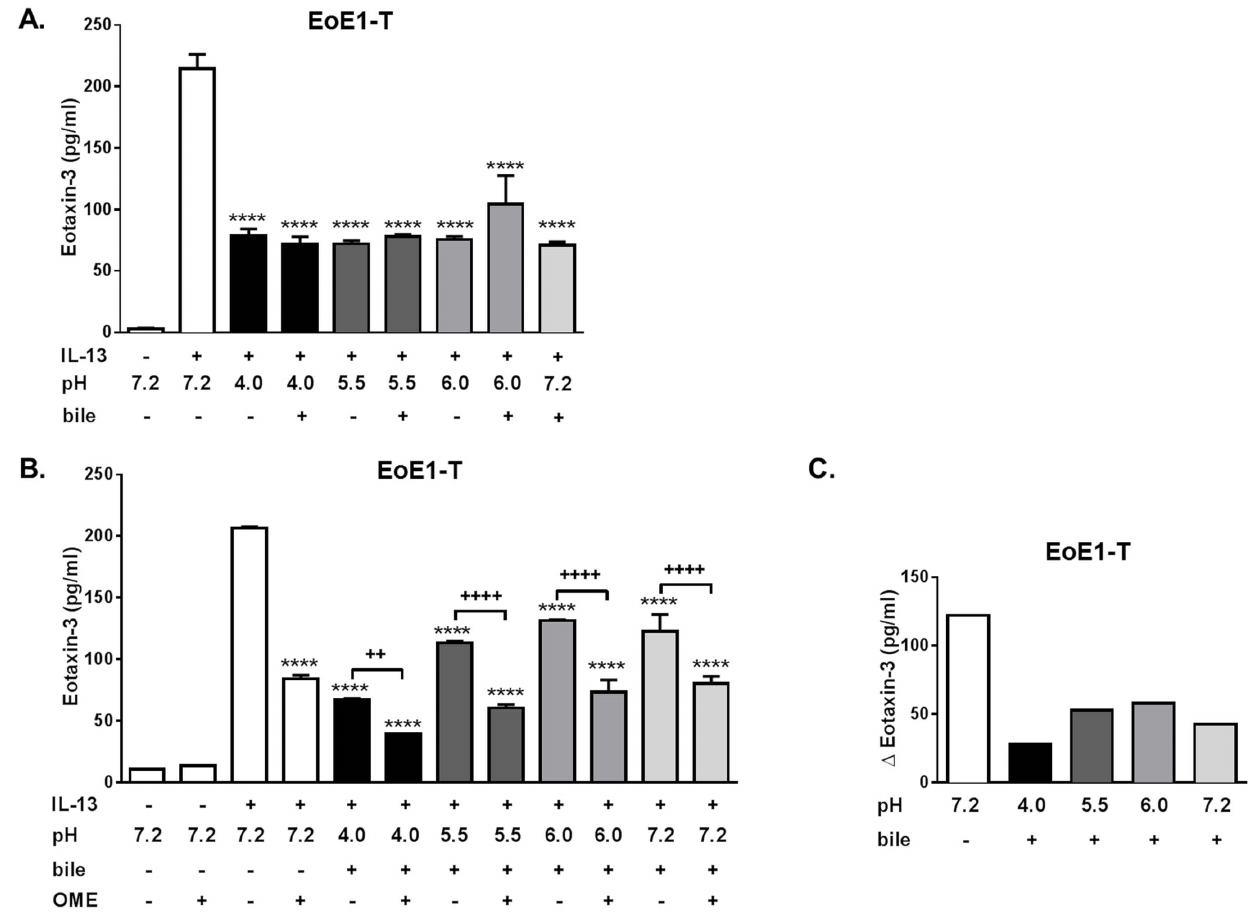
Figure 6. Acid and bile salt effects and PPI anti-inflammatory effects on IL-13-induced eotaxin-3 protein secretion in EoE1-T cells. (A) Acid and/or bile salt effects on IL-13-induced eotaxin-3 protein secretion. Note the profound suppression of eotaxin-3 protein secretion with exposures to acid alone, bile salts alone, or the combination of acid and bile salts. Data are mean 6 SEM of 2 experiments. ****P , 0.0001 compared to IL-13 alone (pH 7.2 with no bile). (B) Combined effects of acid-bile salt medium and omeprazole (OME) on IL-13-induced eotaxin-3 protein secretion. Data are mean 6 SEM of 2 experiments. ****P , 0.0001 compared to IL-13 alone (pH 7.2, no bile, no OME). ++ P , 0.01and ++++ P , 0.0001. (C) Graph depicts the magnitude of the decrease in IL-13-stimulated eotaxin-3 secretion achieved by omeprazole for each acid-bile salt exposure